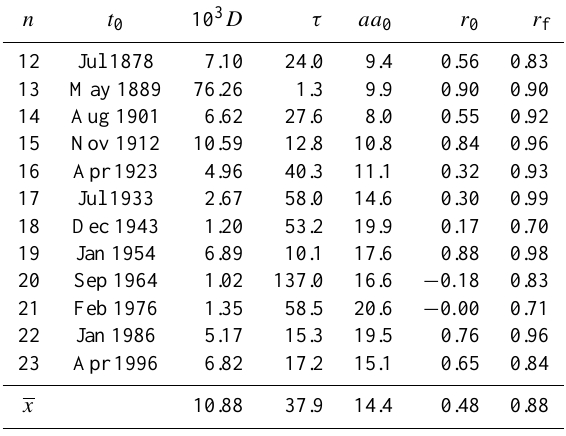
Table 2. Fitted parameters of D , τ and aa 0 , and the correlation